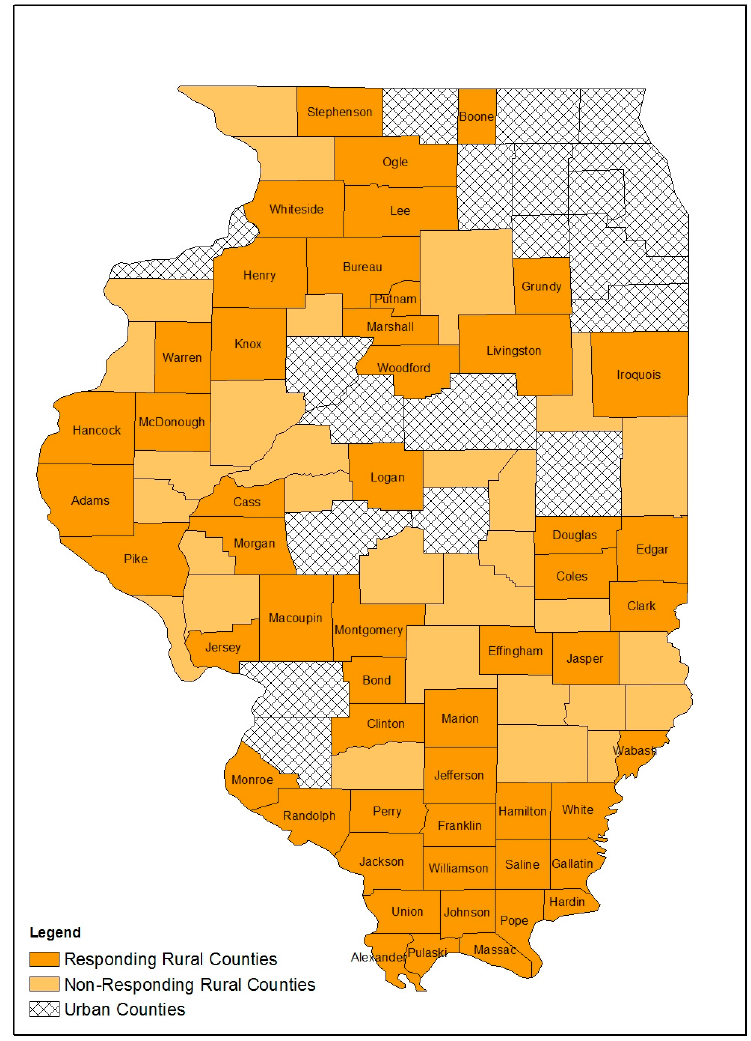
Figure 1. Respondent rural counties, non-respondent rural counties and urban counties, Illinois, 2018.